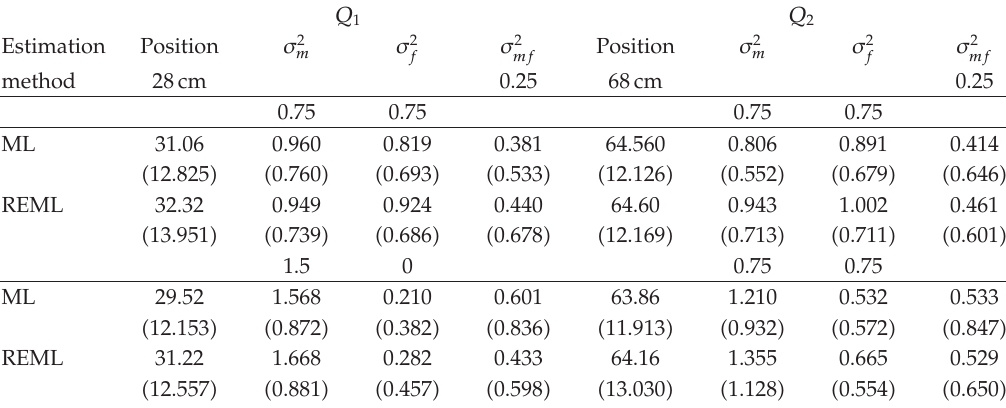
Table 5: The MLEs and REMLs of the QTL position and e ff ect parameters estimated based on 100 simulation replicates for data simulated with two QTL under the 20 × 20 design. The square roots of the mean squared errors are given in